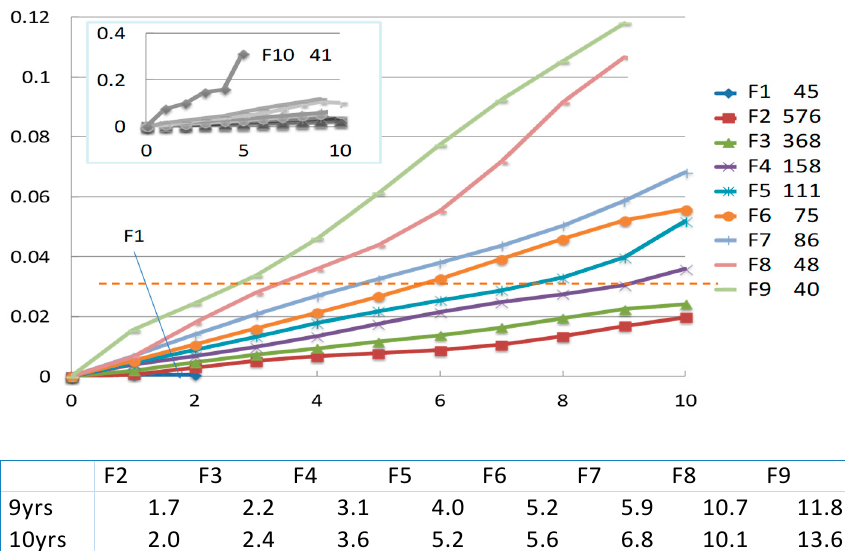
Figure 19. TSDPs of Crisk-rating classes.